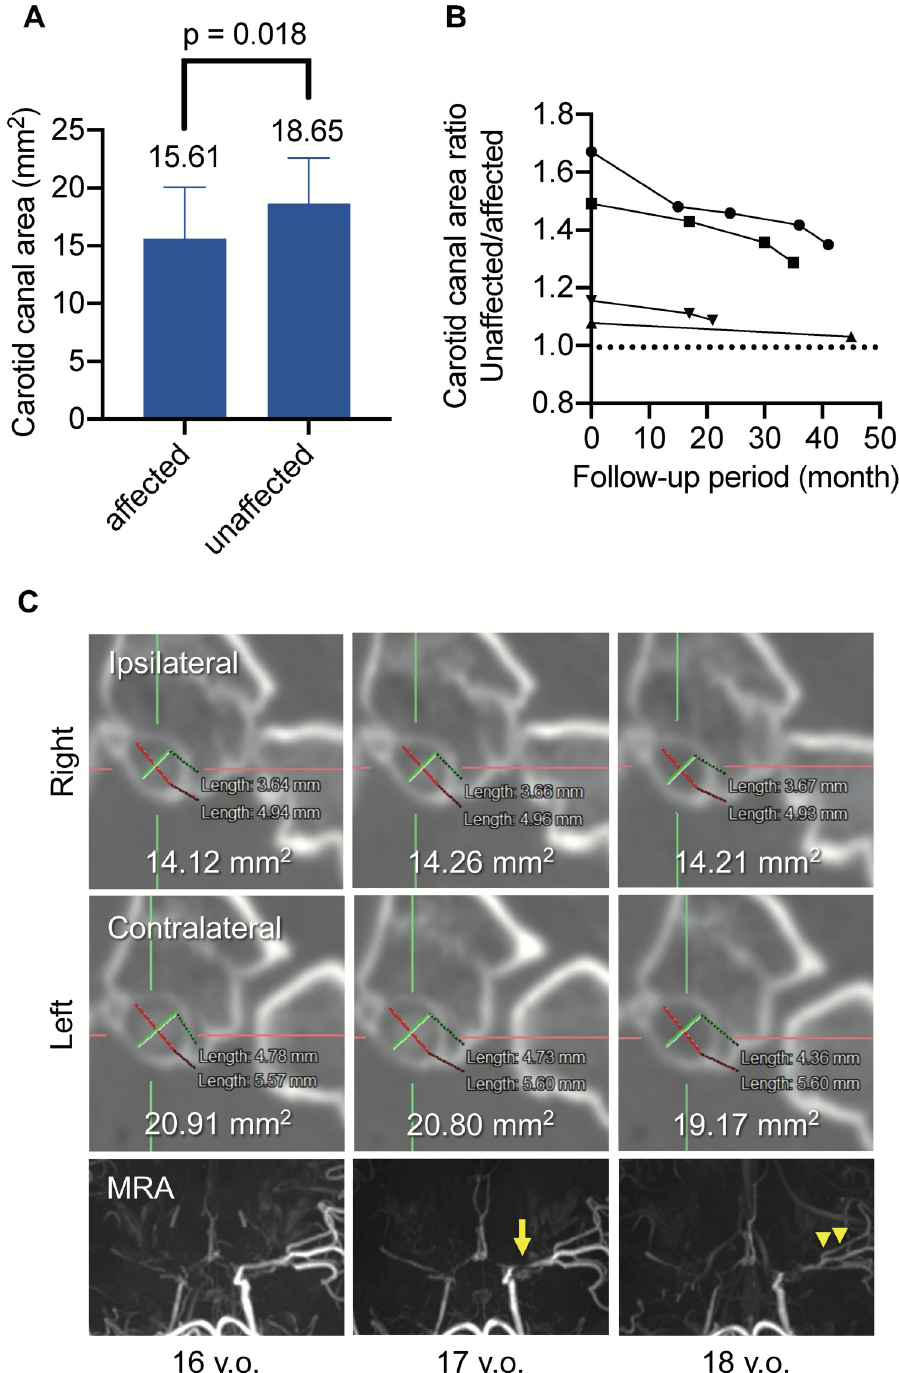
Fig 2. The carotid canal area is larger on the unaffected side than on the affected side in patients with unilateral moyamoya disease, but the difference decreases according to the contralateral progression. (A) shows the carotid canal area compared between the affected side and the unaffected side in patients with unilateral moyamoya disease, and the unaffected side is significantly wider than the affected side (p = 0.018). (B) shows the carotid canal area measured serially in four patients who experienced contralateral progression. The first CT was performed at diagnosis, and the second CT was performed after contralateral progression. Subsequent CT scans were performed when further progression occurred. The carotid canal on the opposite side; i.e., the ipsilateral or affected side, is used as an internal control, and the ratio of unaffected/affected side of the carotid canal area is calculated. The ratio decreases according